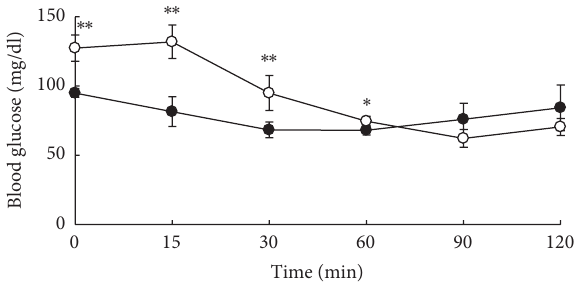
Figure 3: Insulin tolerance test. Blood glucose levels were measured after abdominal administration of insulin (0.75 IU/Kg) to nonfast- ing male LEA ( 𝑛 = 4 , open circle) and Wistar rats ( 𝑛 = 4 , closed circle) at 12 months of age. Significant reduction ( 𝑃 < 0.01 ) in blood glucose levels of LEA and Wistar rats was shown with measuring times after insulin injection. Each value is expressed as the mean ± SD. ∗ 𝑃 < 0.05 . ∗∗ 𝑃 < 0.01